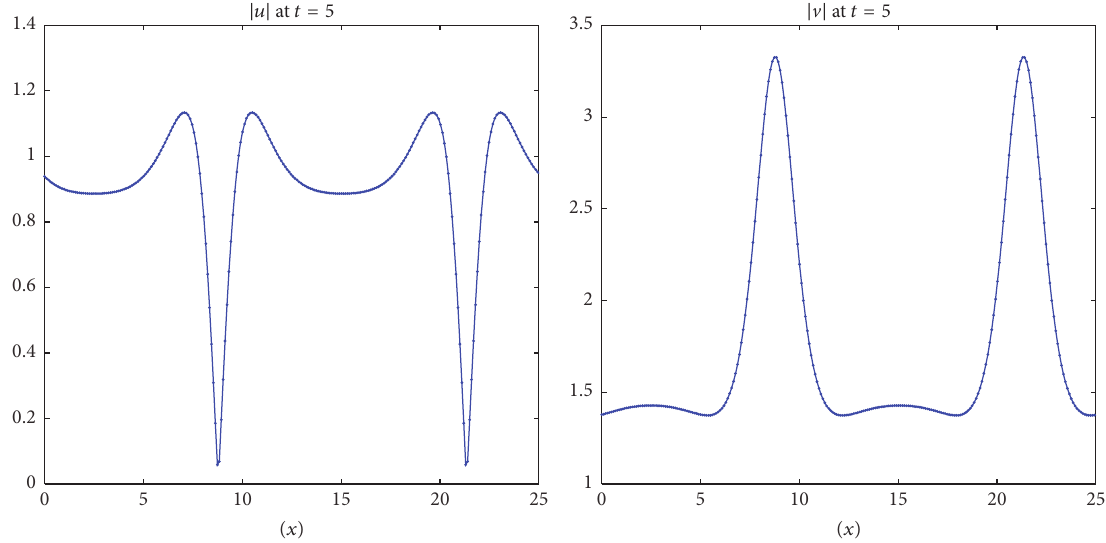
Figure 3: Approximations of the functions 𝜙,𝜓 in the travelling wave solution (104). |u| at t = 5